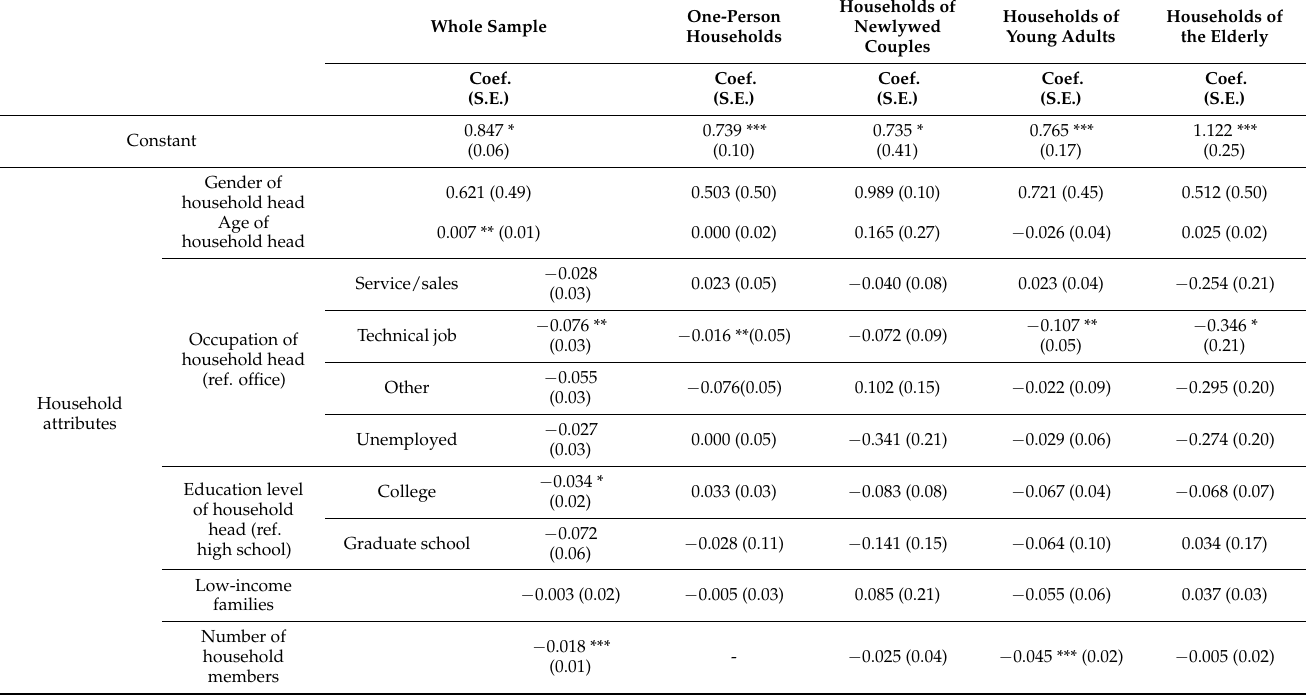
Table 3. Results of residential satisfaction